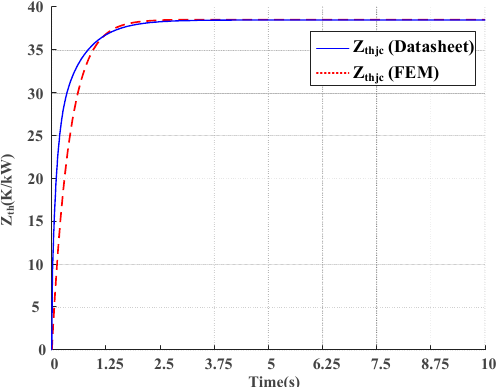
Figure 10. Thermal impedance curves between FEM extraction results and datasheet parameters.